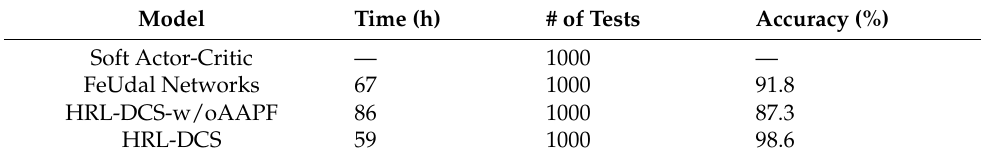
Figure 6. Training convergence of different models. Table 1. Results of different